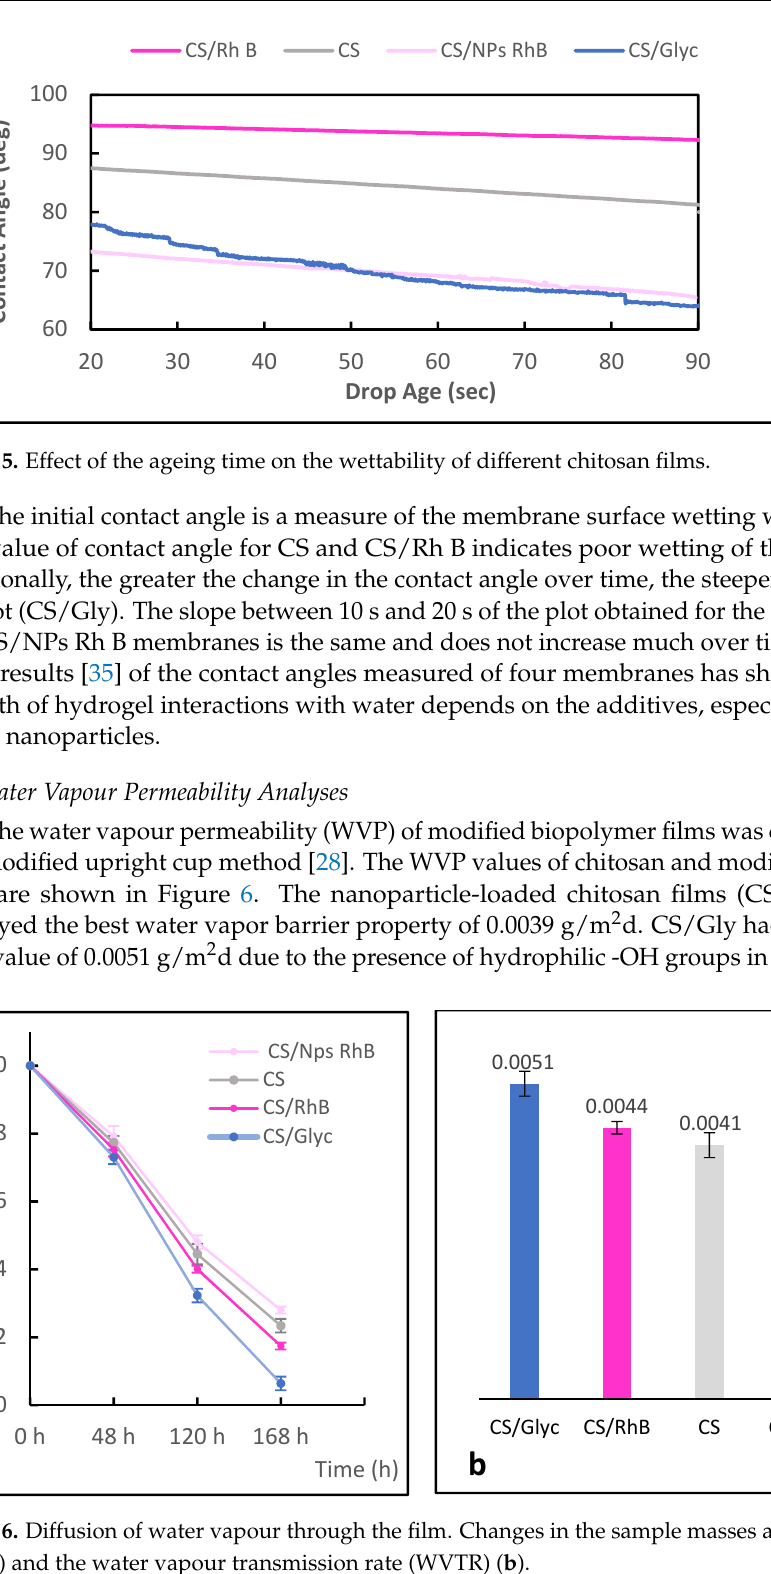
Figure 7. Modified chitosan hydrogel after a few weeks at room temperature: ( left ) chitosan membrane CS/Rh B ( left ) and CS/ NPs ( right ). 3.5. Formation of Modified Chitosan Beads The formation of chitosan beads involves the neutralisation of each droplet of chi- tosan acetic acid solution. Neutralisation is carried out in an alkaline solution. The neu- tralisation process generates a hydrogel bead that contains water and chitosan copolymer with -NH 2 group. Often surfactants, such as dodecyltrimethylammonium bromide (DTAB), sodium dodecylsulphate (SDS), or polyoxyethylene lauryl ether (Brij30), are added to the chitosan solution. An increase in the surfactant concentration increases the